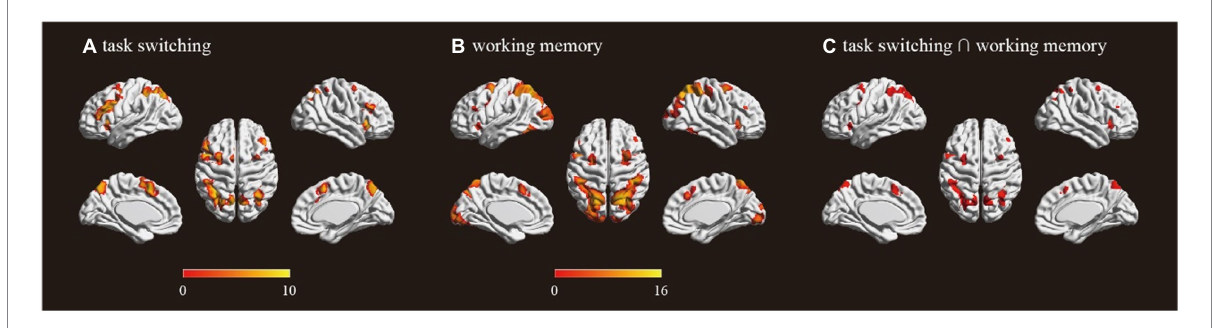
FIGURE 1 Activations for (A) task switching (switch trial > repeat trial); (B) working memory (high working memory > low working memory); (C) overlap of task switching and working memory. Color bar shows a scale of the t values and all results were corrected at p < 0.05 by FWE (Family-wise